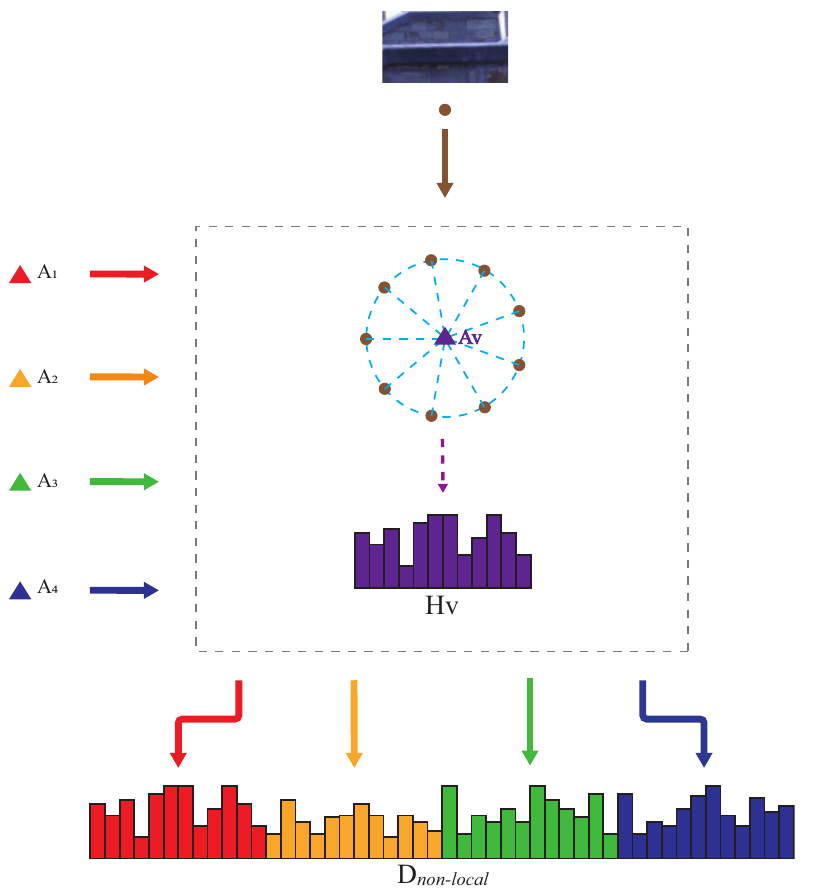
Figure 7. Demonstration of non-local descriptor construction